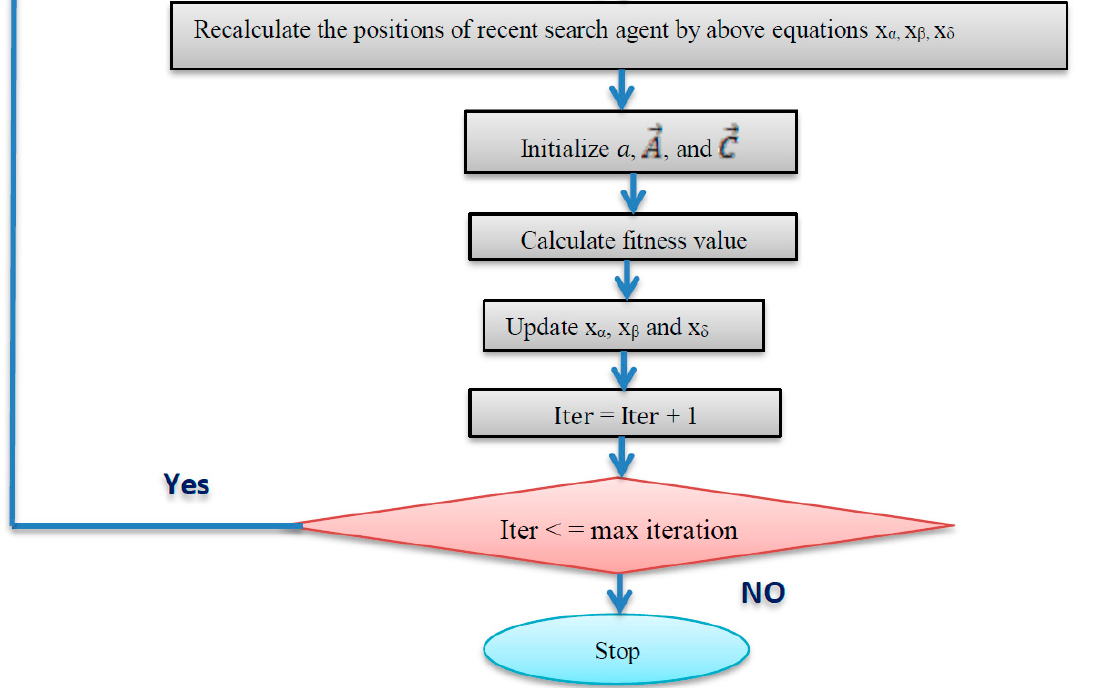
Figure 8. Flowchart of the grey wolf optimization algorithm.